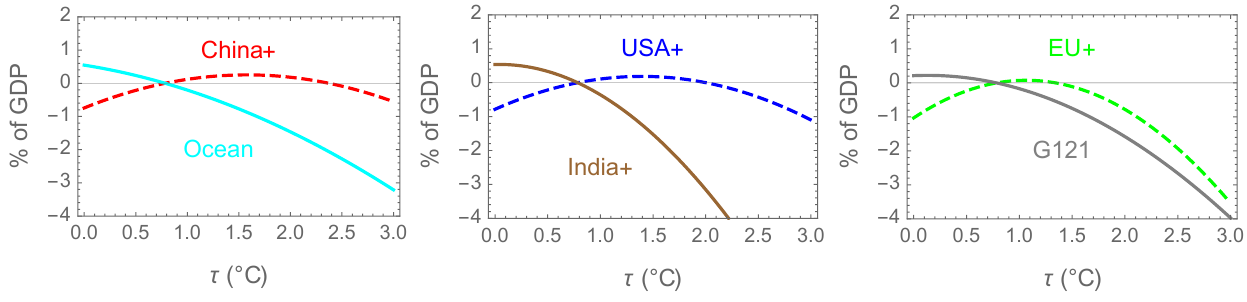
Figure 5. Change in gross domestic product (GDP) in each region vs. global average